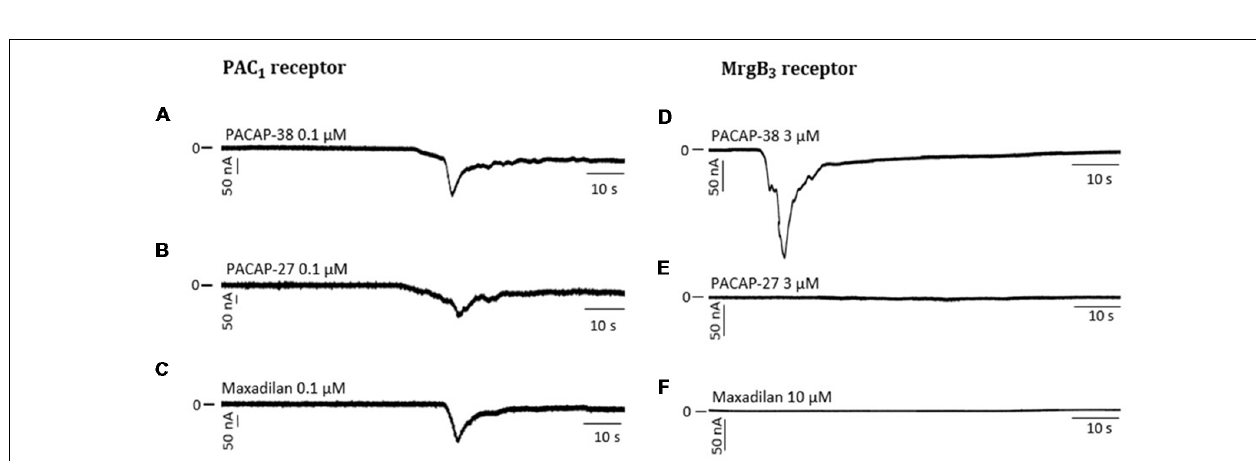
FIGURE 5 | Representative traces showing a change in current after perfusion with PACAP-38 (A) , PACAP-27 (B) and maxadilan (C) on PAC 1 -receptor-expressing Xenopus laevis oocytes ( A to C ). In MrgB 3 -receptor-expressing Xenopus laevis oocytes ( D to F ) PACAP-38 caused a change in current (D) while there was no change after perfusion with PACAP-27 (E) and maxadilan (F) . The membrane potential was clamped to − 70 mV. Scale bars represent 50 nA and 10